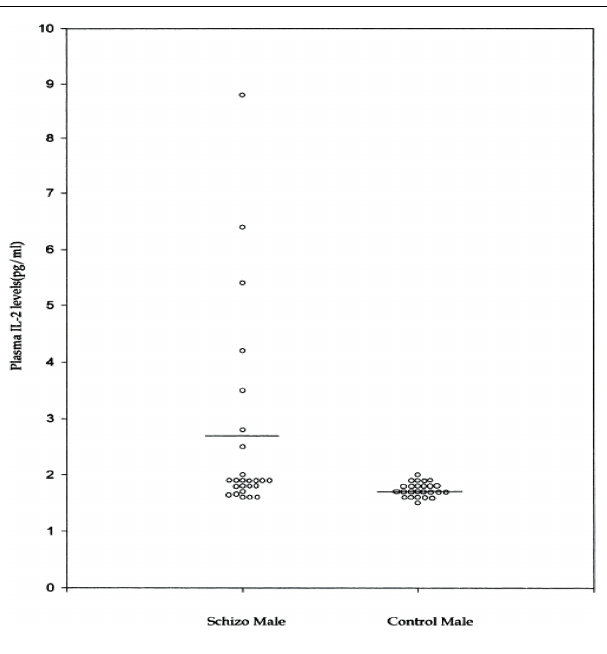
FIGURE 7 | Plasma IL-2 levels in male schizophrenic patients and normal controls (Kim etal., 2000). Notice two